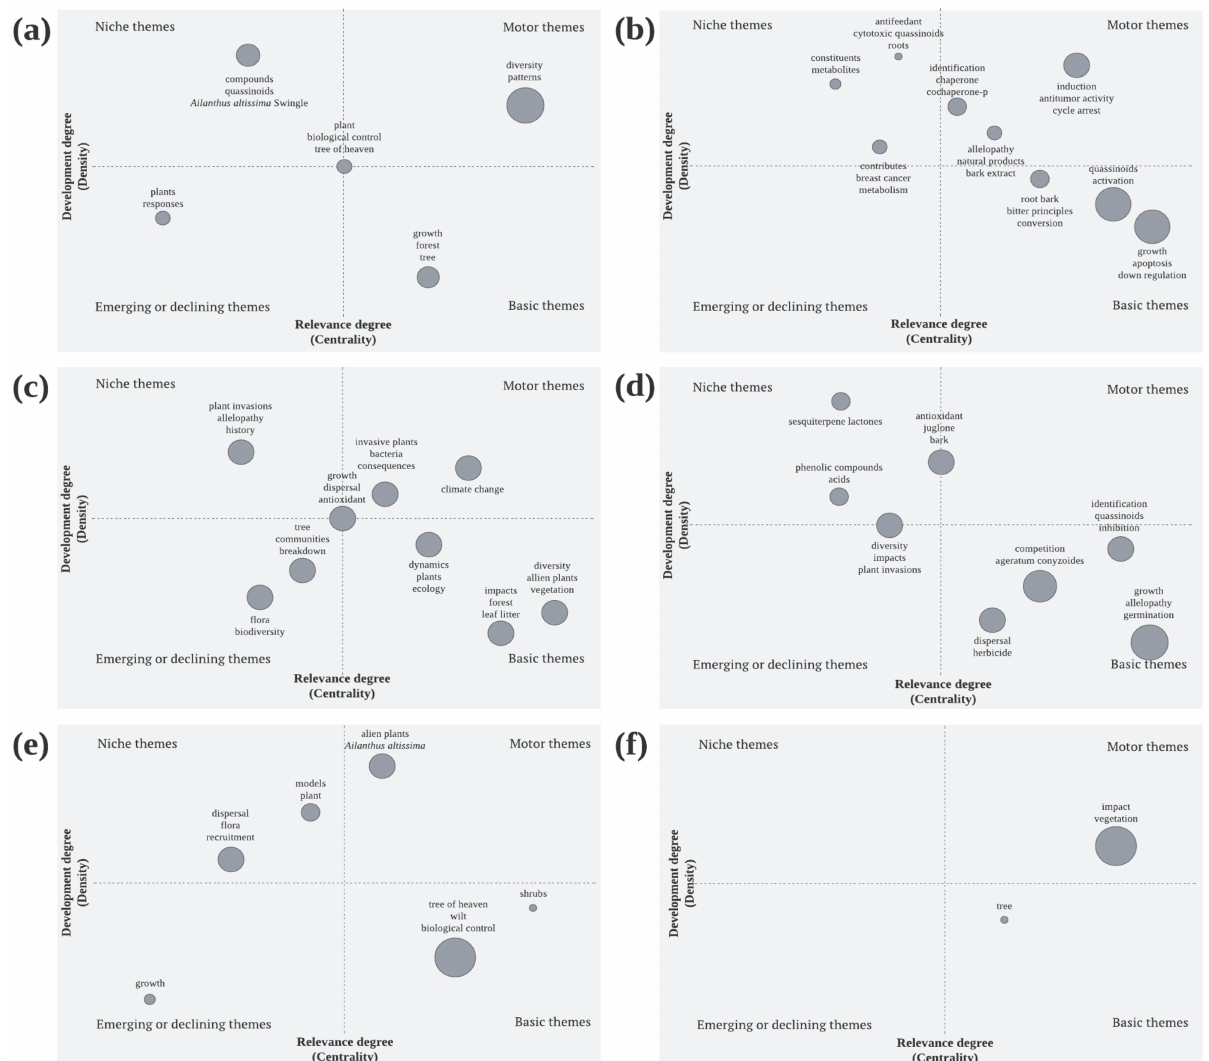
Figure 3. Distribution of thematic areas for each set of keywords used in the search in the Web of Science database and which were processed in the Bibliometrix package (Biblioshiny routine) in RStudio: ( a ) set of keywords “Ailanthus” and “altissima”; ( b ) “ailanthone”; ( c ) set of keywords “Ailanthus” and “altissima” and “ecosystem” and “impacts”; ( d ) set of keywords “Ailanthus” and “altissima” and “invasive” and “behavior”; ( e ) set of keywords “Ailanthus” and “altissima” and “allelopathy”; and ( f ) set of keywords “Ailanthus” and “altissima” and “control” and